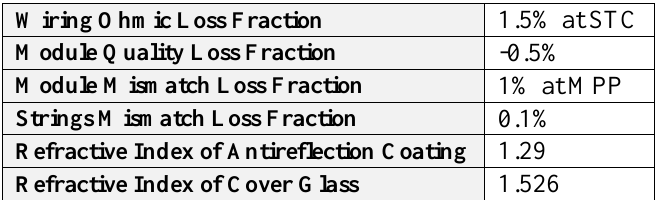
Table 5: Array loss factors from wires and